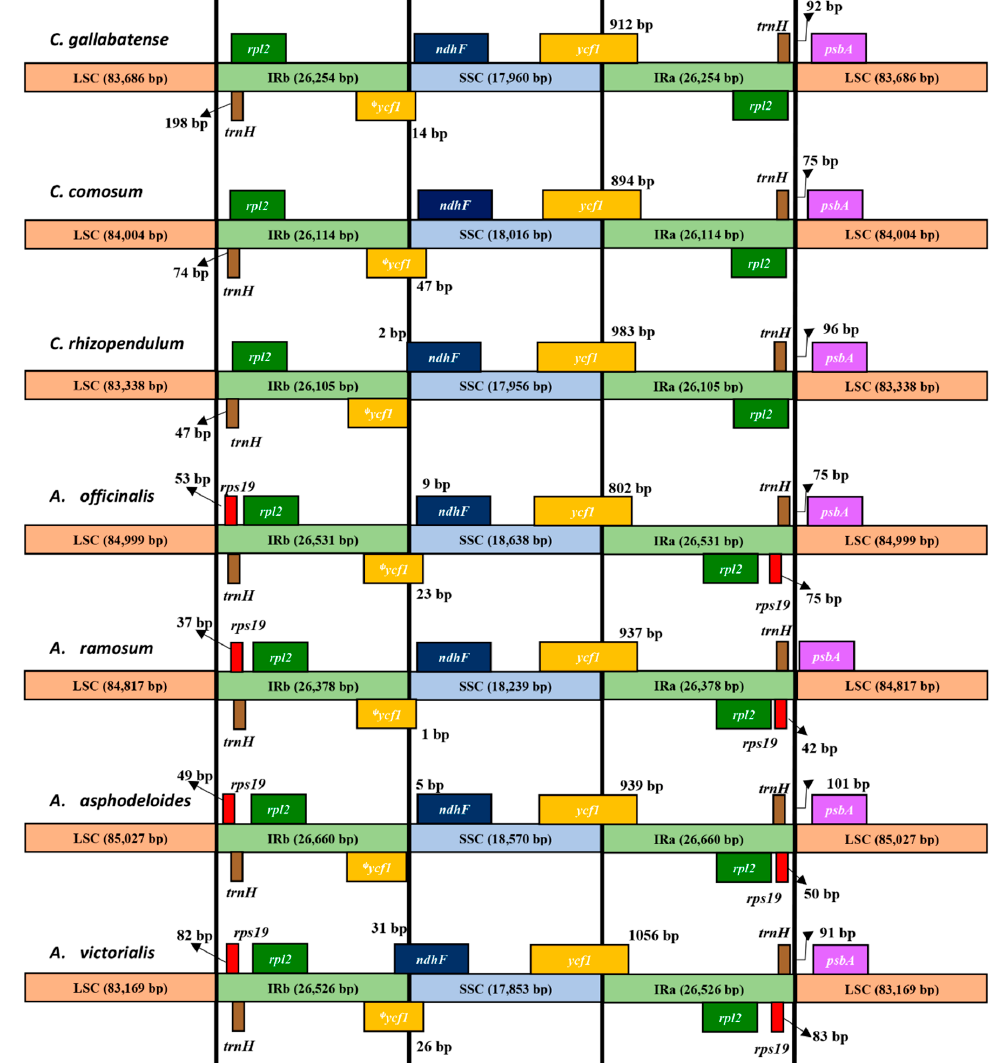
Figure 5. Comparison of the junctions of LSC, SSC, and IR regions among seven chloroplast genomes.